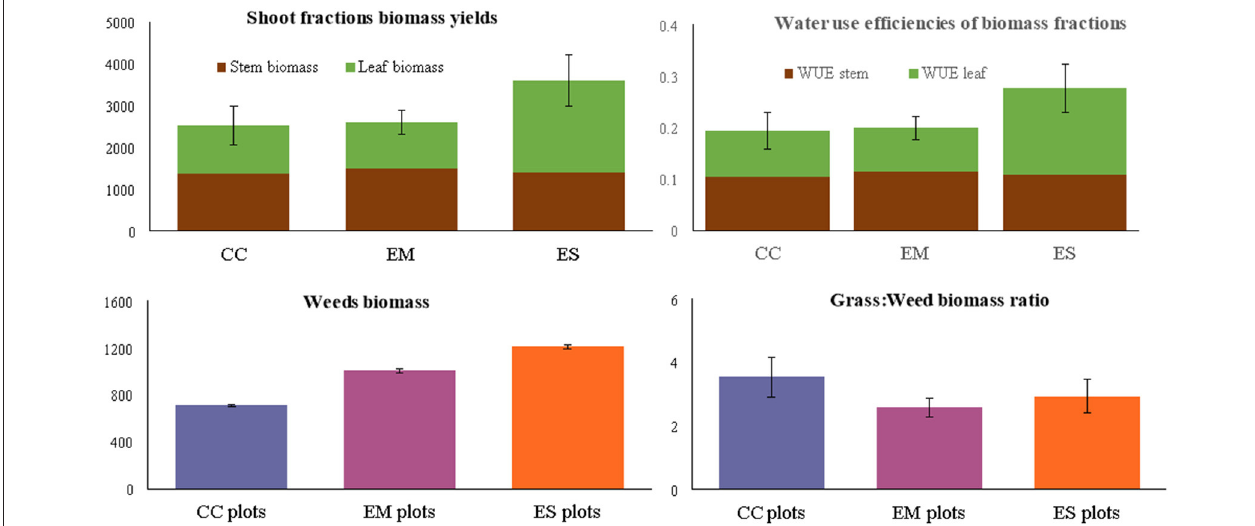
FIGURE 4 | Biomass yields (kg DM ha − 1 ) water use efficiencies (DM ha − 1 mm − 1 ), weed biomass (kg DM ha − 1 ) and grass-weed biomass ratio of three African rangeland grasses used for ecological restoration 9 months after establishment. Where CC, Cenchrus ciliaris; EM , Enteropogon macrostachyus; ES , Eragrostis superba. Error bars represents standard error ( ± SE) of means ( n =